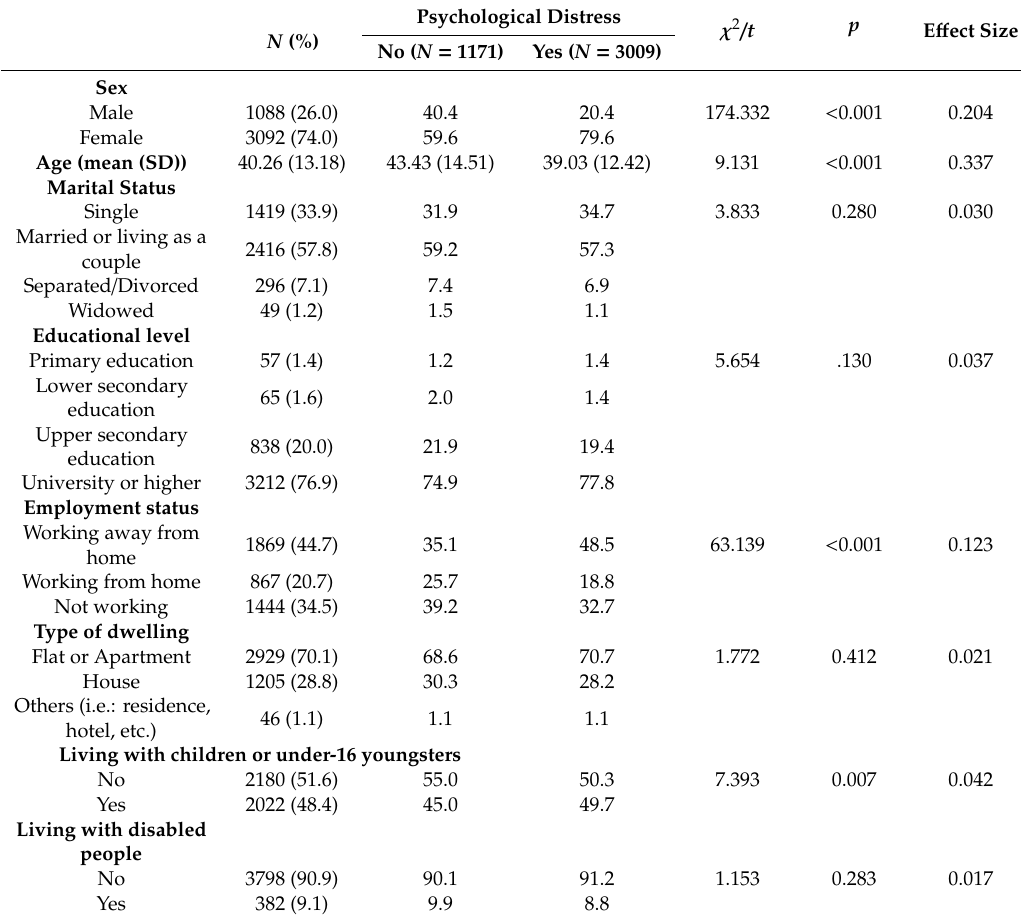
Table 2. Association between sociodemographic variables and psychological distress during the COVID-19 pandemic (N =